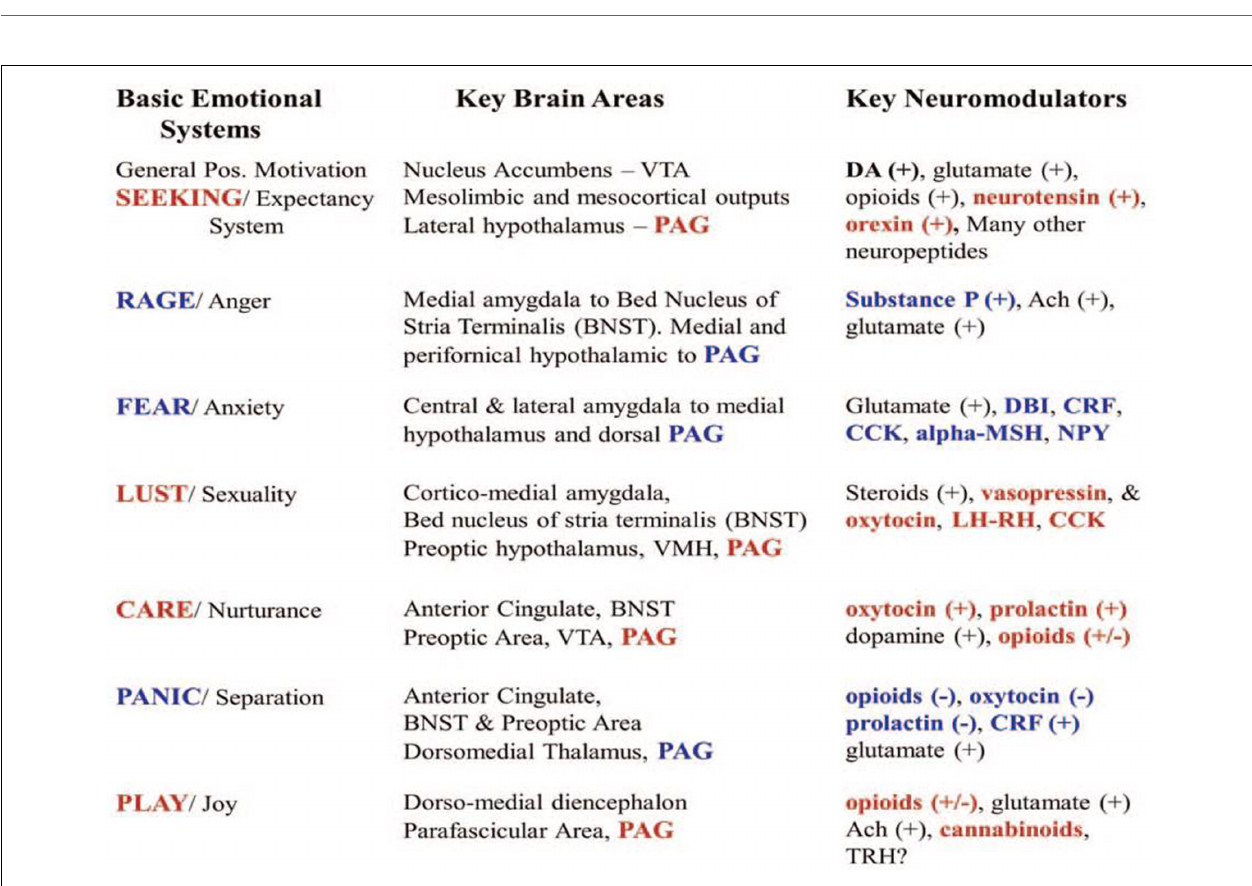
FIGURE 3 | List of the Basic Emotional Systems with their neuroanatomy and neurochemistry. Red color refers to positive-appetitive emotional dispositions, while the blue color refers to negative-aversive emotional dispositions. Ach, achetilcholine; alpha-MSH, alpha-melanocyte stimulating hormone; BNST (bed nucleus of the stria terminalis); CCK, cholecystokinin; CRF, corticotropin releasing factor; DA, dopamine; DBI, diazepam binding inhibitor; LH-RH, luteinizing hormone-releasing hormone; NPY, neuropeptide Y; PAG, periacqueductal gray; TRH, thyrotropin-releasing hormone; VTA, ventral tegmental